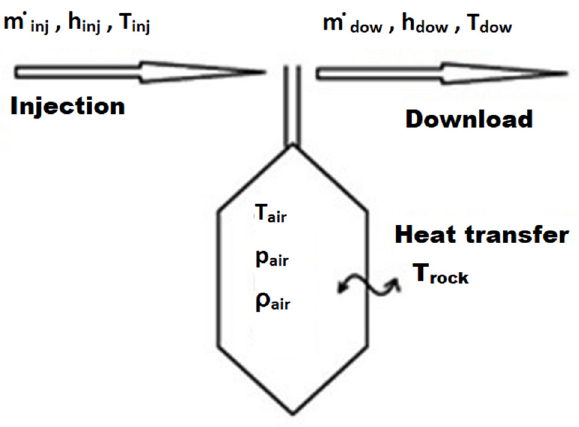
Figure 1. Considered parameters during the injection and download processes from a cavern